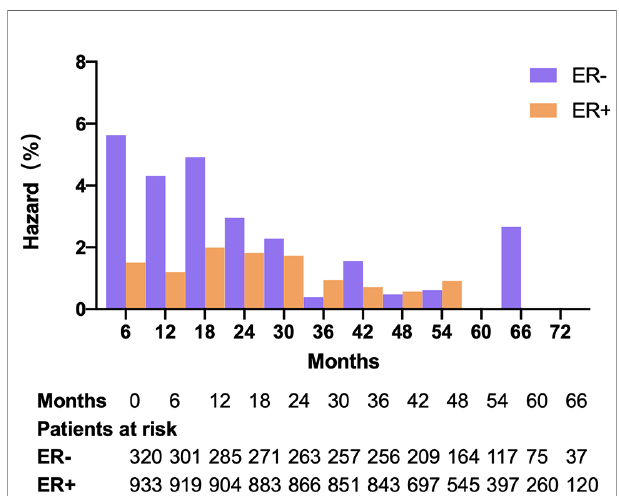
FIGURE 1 | Hazard rate per 6 months in ER-negative patients and ER- positive patients.